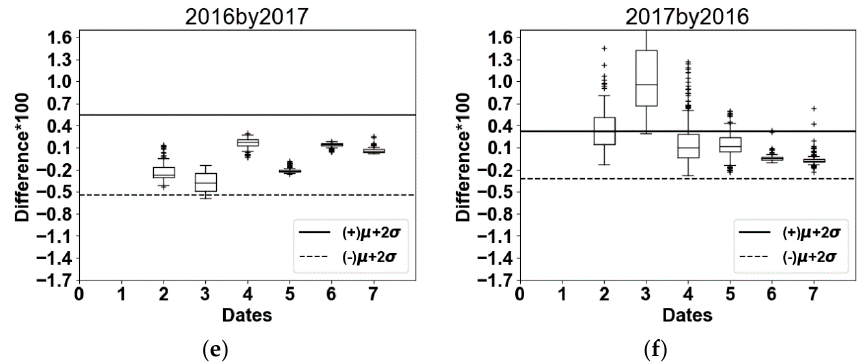
Figure 8. Differences of wheat reference segments when using the thresholds [ μ + 1 σ ] ( a ) 2016 when calibrated by 2017 and ( b ) 2017 when calibrated by 2016, [ μ + 1.5 σ ] ( c ) 2016 when calibrated by 2017 and ( d ) 2017 when calibrated by 2016 and [ μ + 2 σ ] ( e ) 2016 when calibrated by 2017 and ( f ) 2017 when calibrated by 2016.